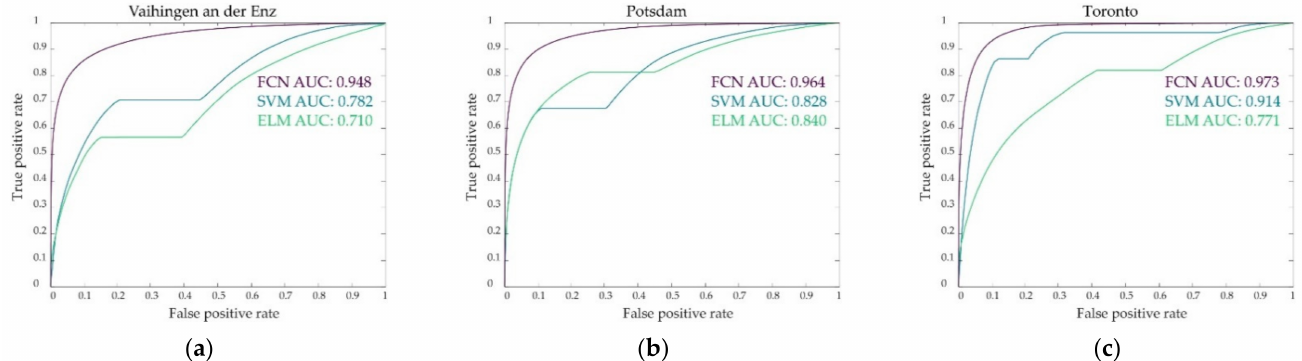
Figure 8. Receiver operating characteristic (ROC) curves of the three models for the different urban areas: ( a ) Vaihingen, ( b ) Potsdam, and ( c )